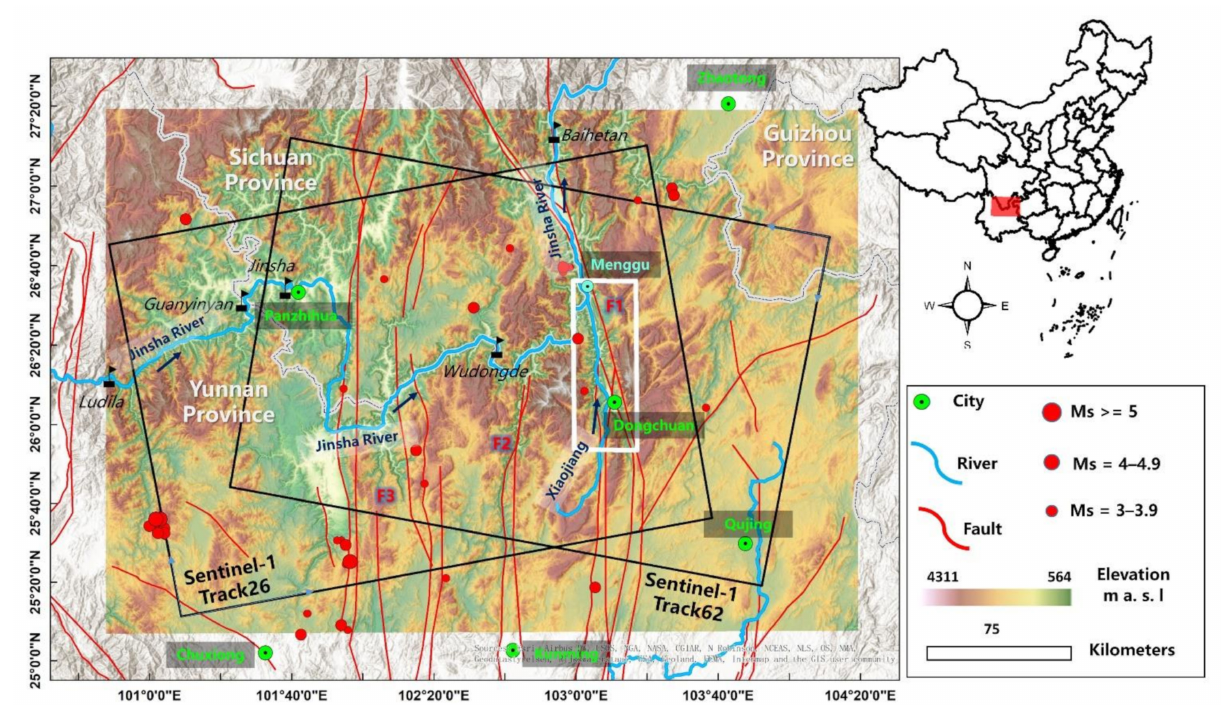
Figure 1. Location of the study area and coverage of the SAR images, with SRTM DEM as the base map. White and black rectangles illustrate the study area and the coverage of SAR images, respectively. Blue lines represent the Jinsha River and its tributary, Xiaojiang River, and black flag icons are hydropower stations. Red lines represent the active faults, where F1: Xiaojiang Fault, F2: Pudu River Fault, F3: Yuanmou Fault. Red dots are the earthquakes that occurred in the study area and vicinity during the period of 2009 to 2019 (information acquired from Unified earthquake catalogue of China Seismic